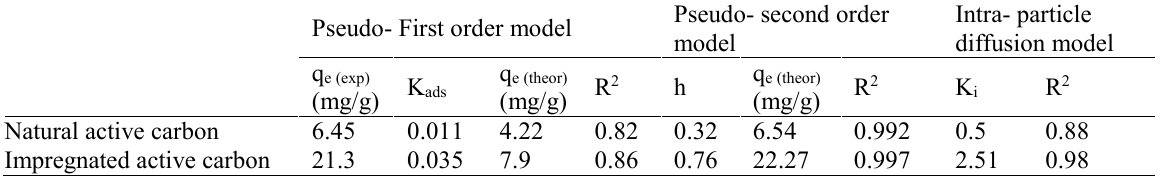
Table 3. Kinetic constants of Mn 2+ adsorption onto active